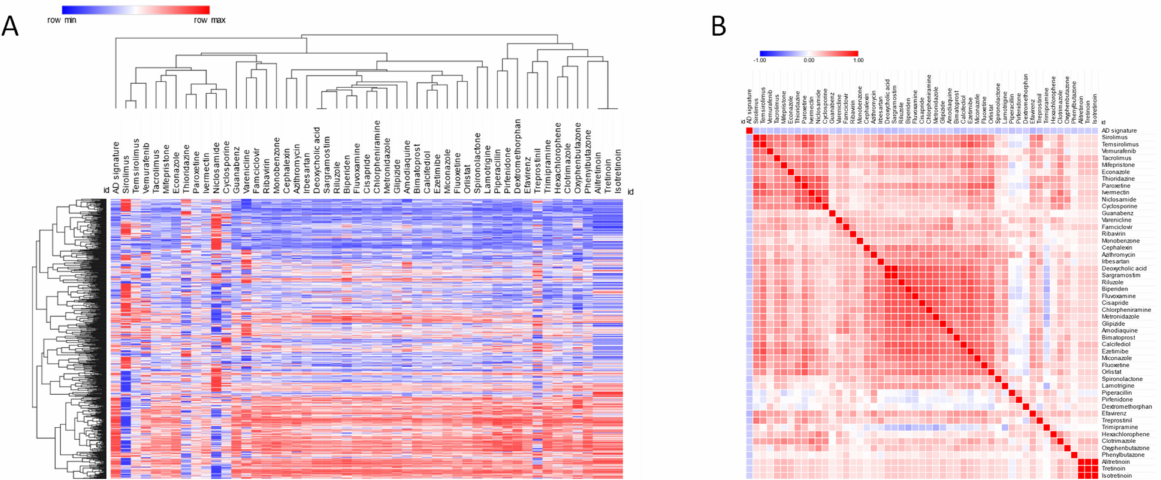
Figure 3. For the prediction of drugs potentially repurposable for AD, the cosine distance was calculated between the AD signature, identified from the meta-analysis of the GSE118554 and the GSE48350 data sets, and the meta-signatures of FDA-approved drugs derived from the LINCS L1000 database; ( A ) hierarchical clustering for the top 50 predicted drugs; ( B ) similarity matrix for the top 50 predicted